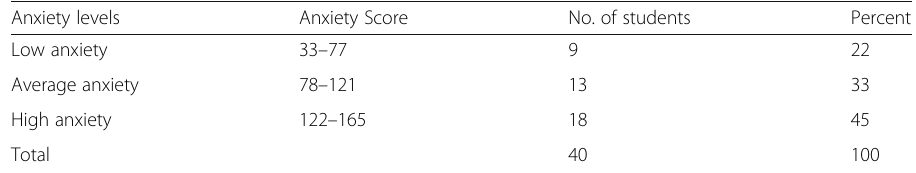
Table 3 Distribution of the participants ’ FL Listening Anxiety Levels Anxiety levels